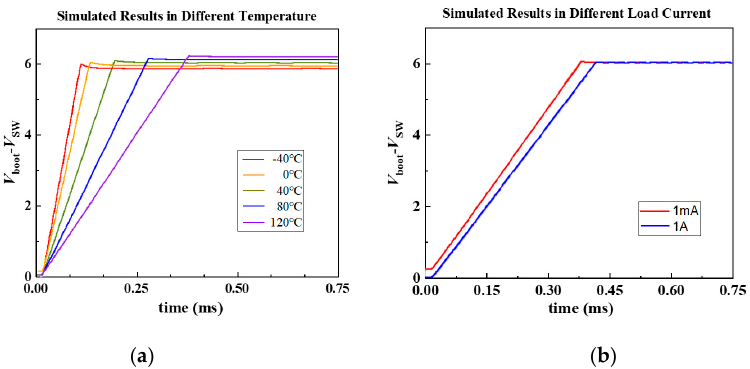
Figure 10. Simulation result at ( a ) different temperature (T = − 40 °C, 0 °C, 40 °C, 80 °C and 120 °C) and ( b ) different load current (1 µA and 1 mA).